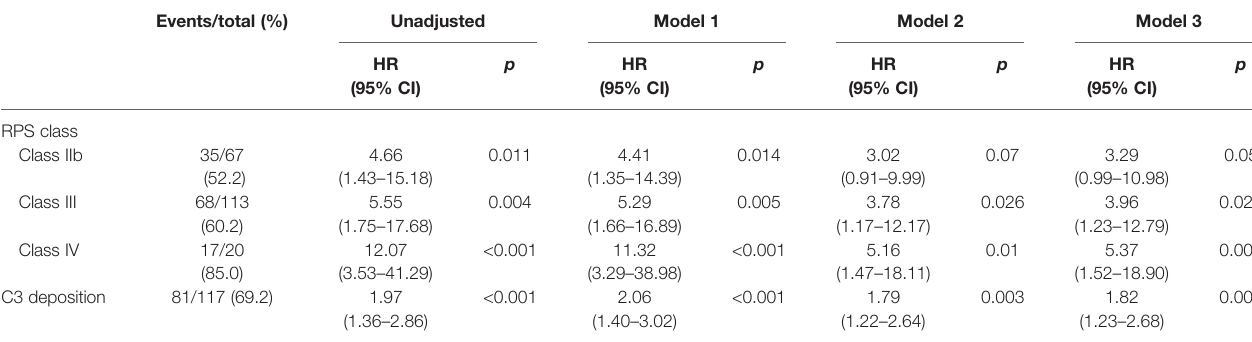
TABLE 4 | Hazard ratios for a composite of ESRD or 50% decline in initial eGFR strati fi ed by glomerular C3 deposits or RPS class. Events/total